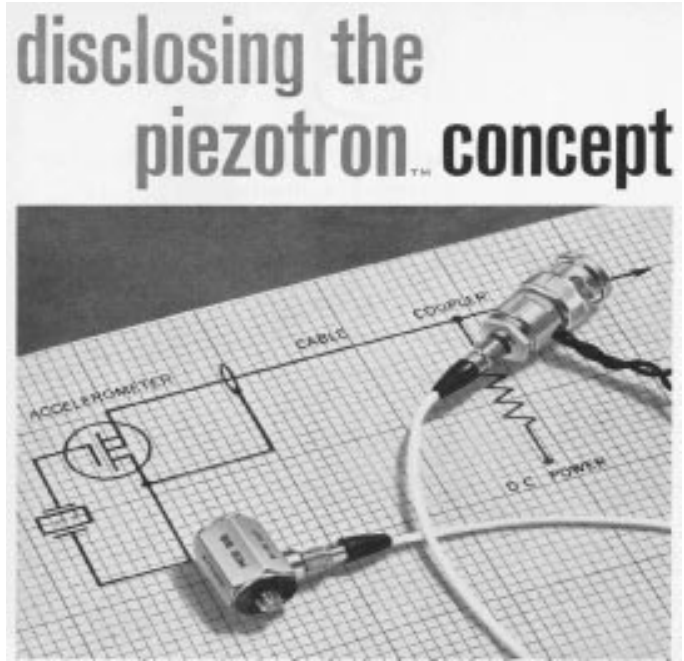
Fig. 3. The first commercial two-wire piezoelectric accelerometer with contained FET (Kistler, about 1963).